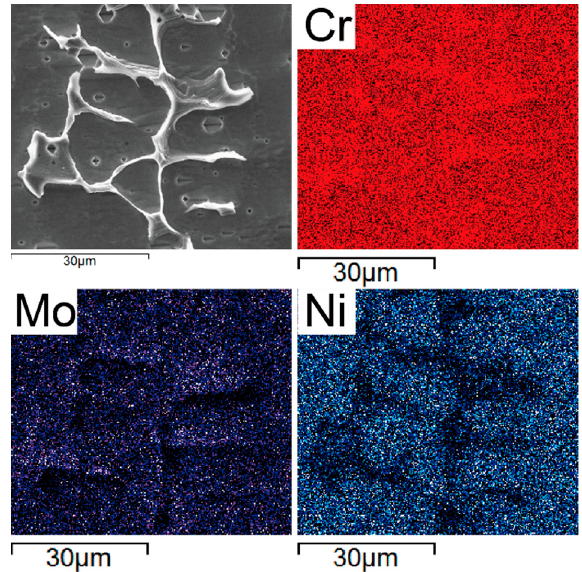
Figure 5. Element distribution of the ferrite and austenite matrix.